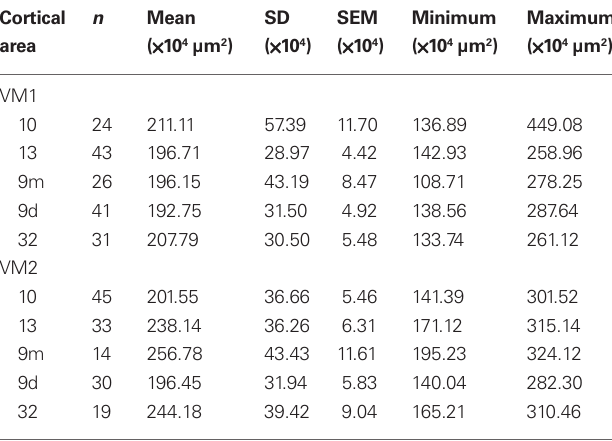
Table 8 | Somata of layer iii pyramidal cells (in the tangential plane) sampled in the prefrontal cortex of the vervet monkey.